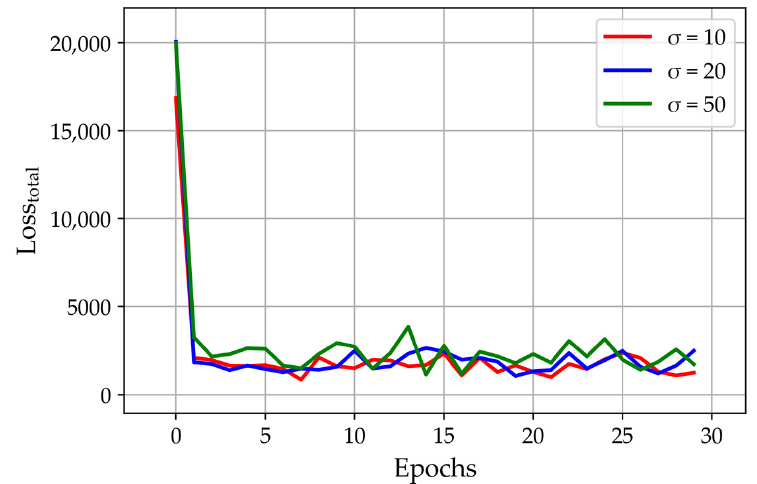
Figure 10. The graph plot of total loss per epoch according to sigma.